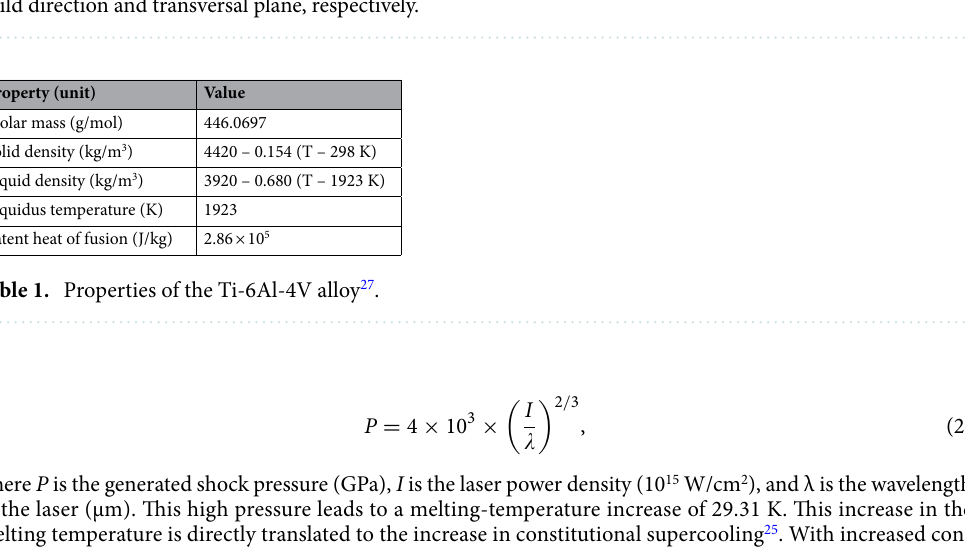
Figure 3. EBSD analysis of the conventional AM ( a , b ) and PLAAM ( c , d ) samples. Inverse pole figure maps for the β phase along the build direction ( a , c ). Contoured pole figures for the β phase ( b , d ). z and (x,y) are the build direction and transversal plane, respectively.